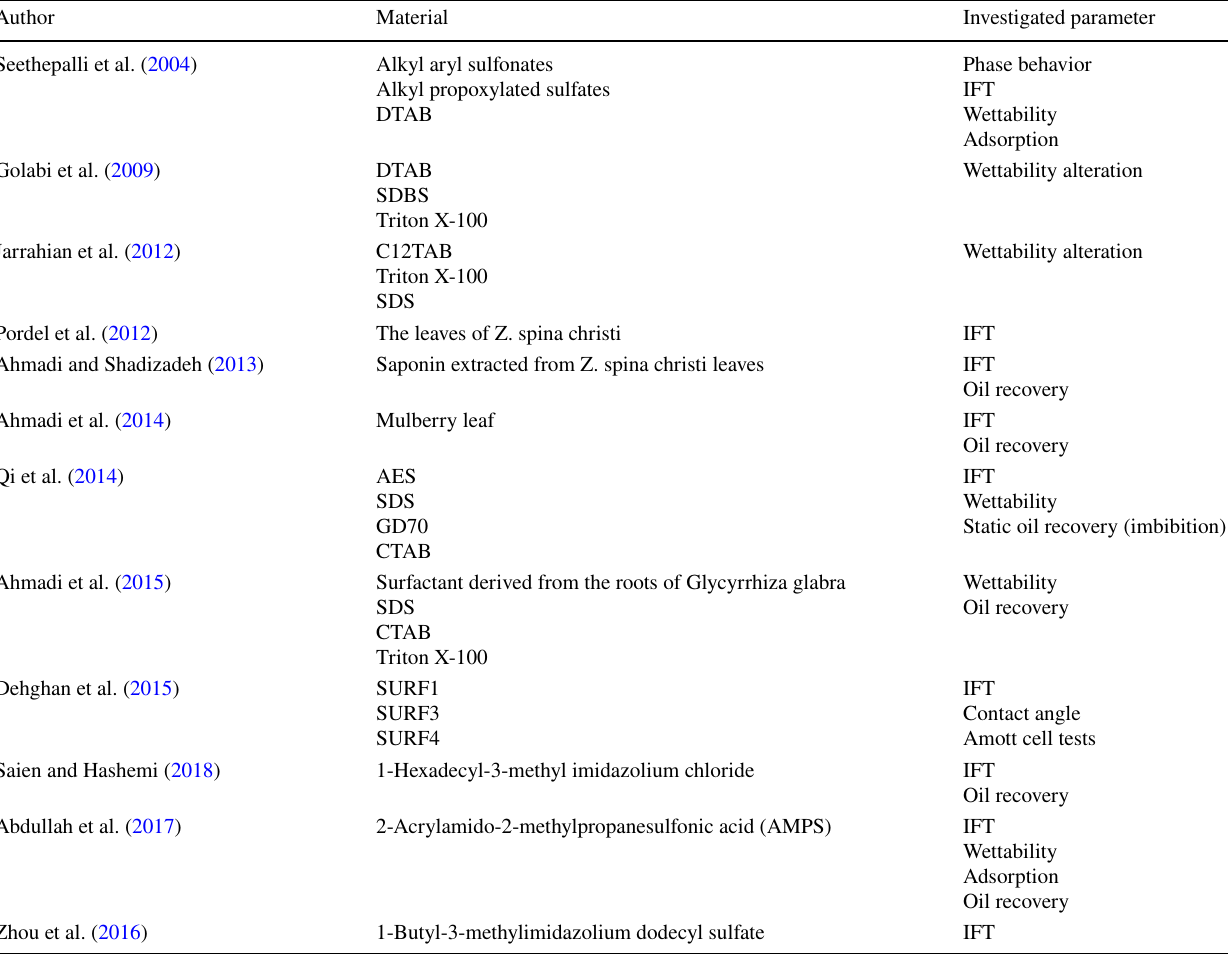
Table 1 Summary of previous studied on application of various surfactants in